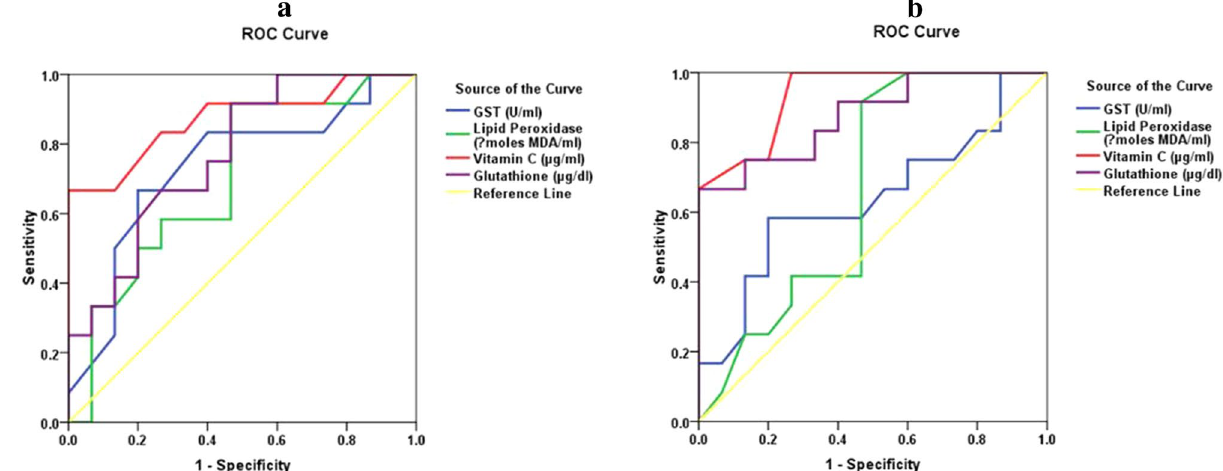
Figure 2. ROC curve of GST (U/ml), lipid peroxidase (μmoles MDA/ml), vitamin C (μg/ml) and glutathione (μg/dl) in (a) diabetes without retinopathy; (b) diabetes with retinopathy group.